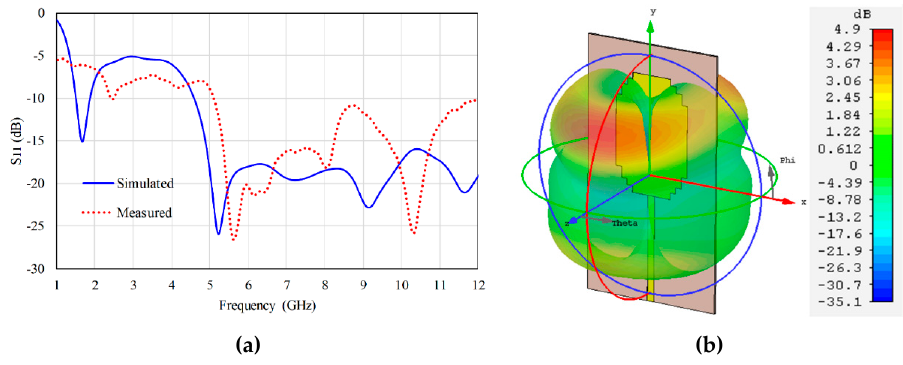
Figure 15. UWB antenna results ( a ) simulated and measured S 11 ( b ) simulated 3D radiation pattern. Table 3. UWB antenna design parameters.